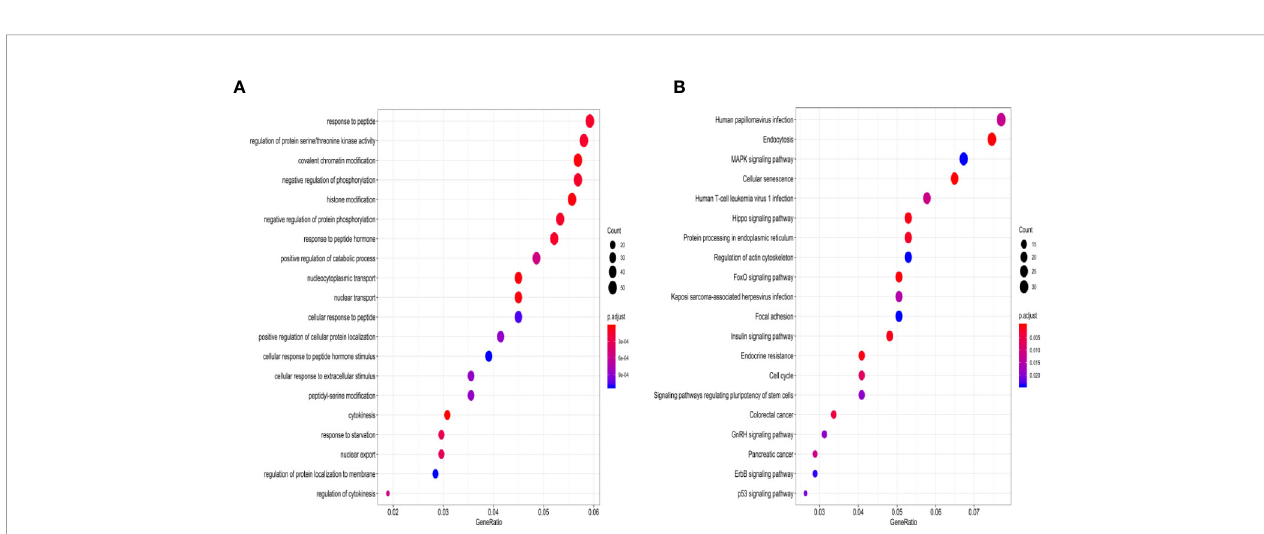
FIGURE 4 | GO enrichment analysis and KEGG pathways enrichment analysis of four-miRNAs targeting mRNAs. (A) The top 20 over-represented biological processes are primarily involved. (B) Signi fi cantly enriched cancer-related KEGG pathways. GO, gene ontology; KEGG, the Kyoto Encyclopedia of Genes and